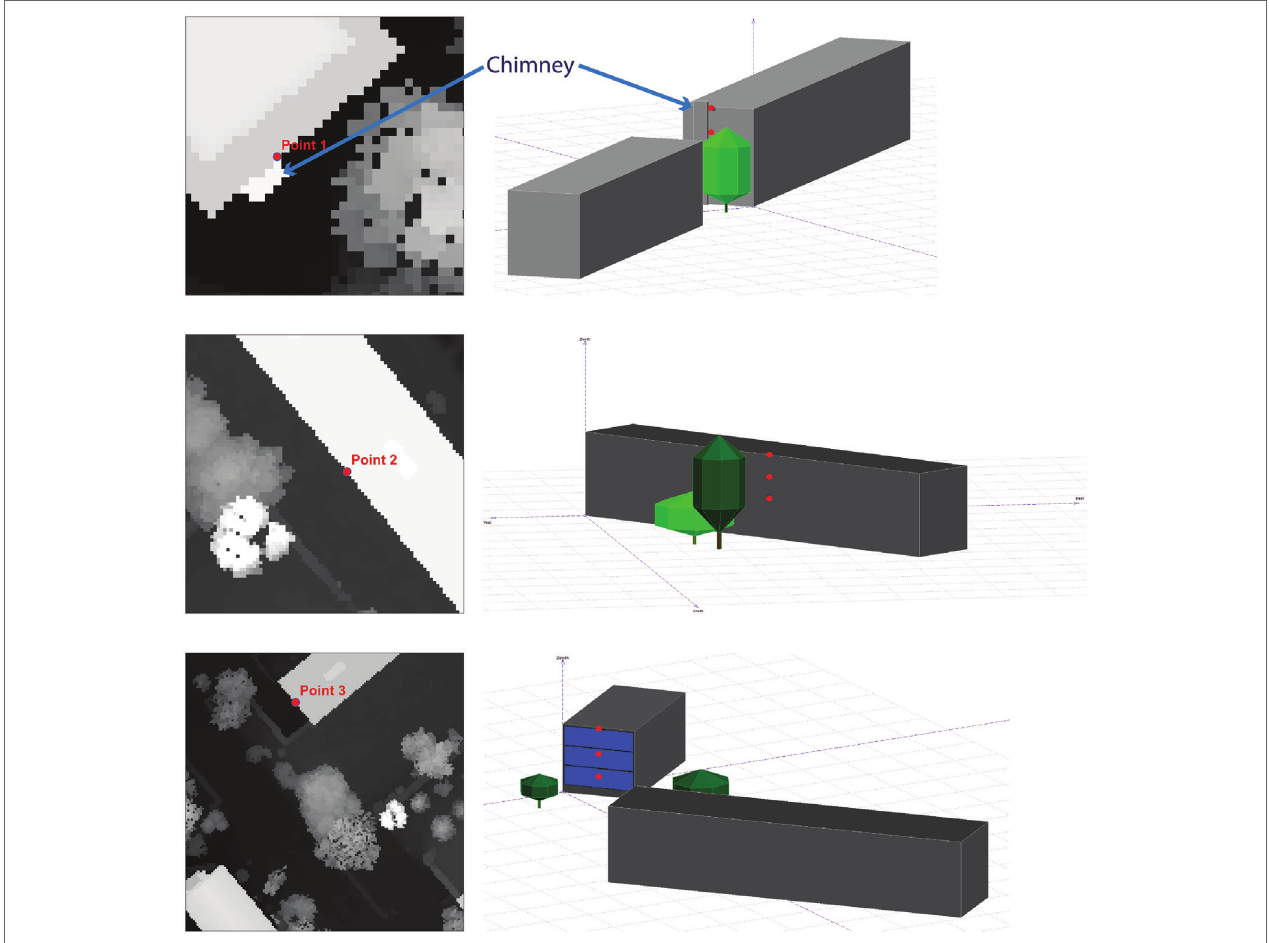
FIGURe 15 | Extracts of the digital surface model (left hand-side images) and 3D modeling with PVSyst (right hand-side images) for the three sets of points